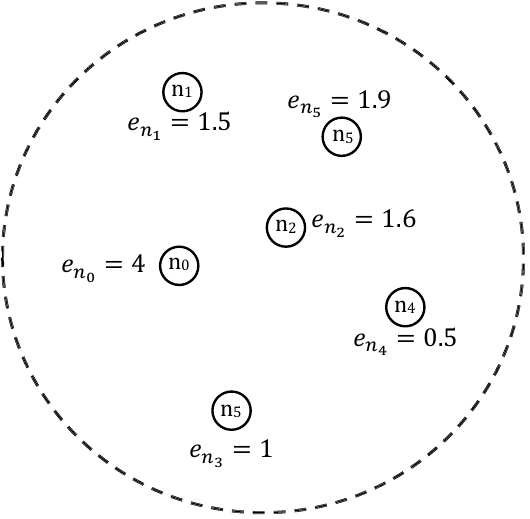
Figure 3. Case2: Nodes { n 0 , n 5 } are candidate cluster head nodes. Another criterion for selecting the CH nodes is estimation of inter cluster head distance ( d ) . For a given wireless sensor network, d opt